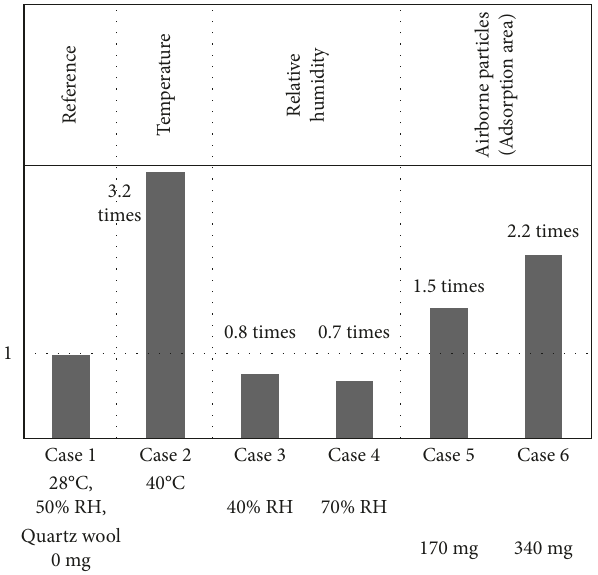
Figure 8: Comparison of DEHP emission rates in the presence of factors influencing this rate.